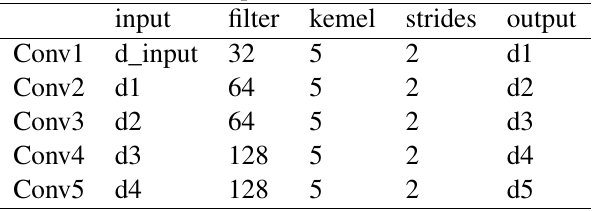
Table 3 Construction parameter list of discriminator